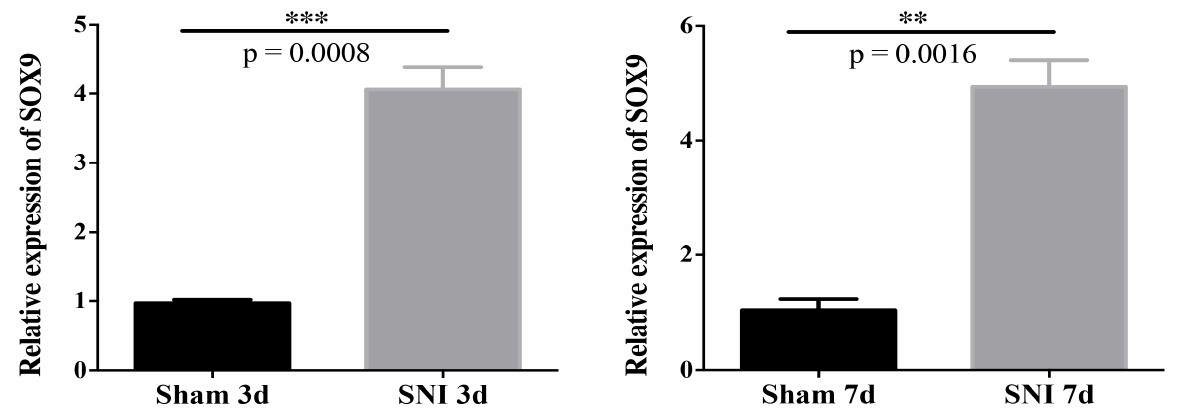
Figure 8. Expression of Sox9 mRNA in SGCs (*** p = 0.0008; ** p = 0.0016).